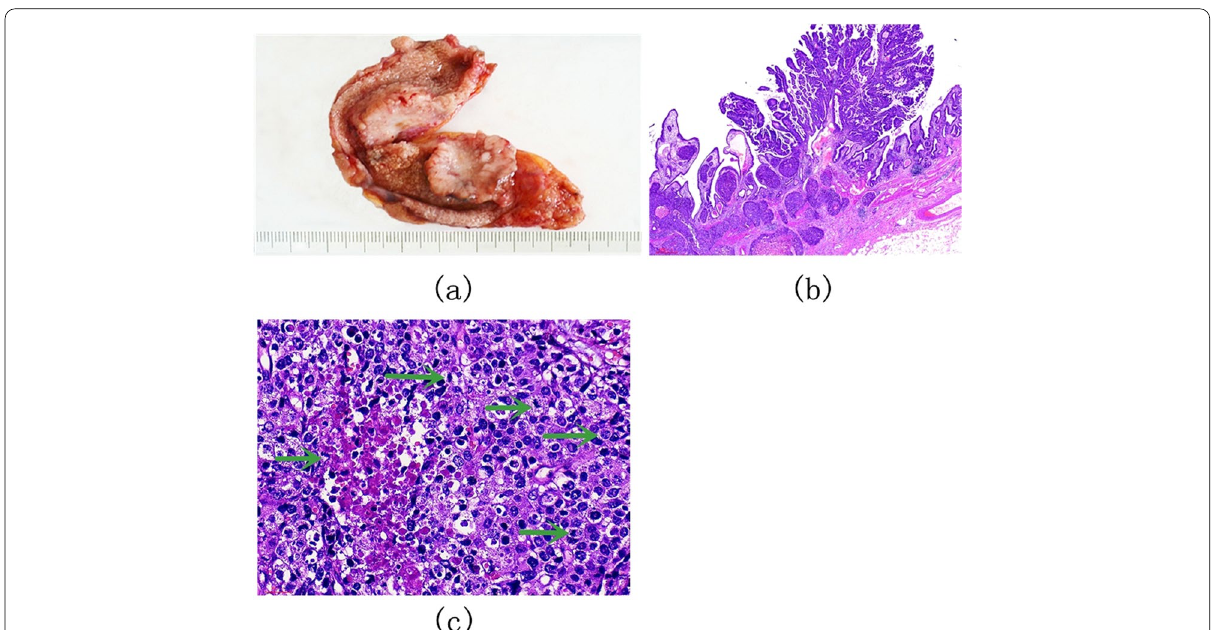
Fig. 4 Case 2: Gross pathological findings of the resected gallbladder and histological findings of MiNEN in the gallbladder, by hematoxylin and eosin (HE) staining. a The body of the gallbladder was a grayish-white type Isp mass. b Two components, LCNEC (lower left, show multiple irregular organoid nests) and moderately differentiated papillary adenocarcinoma (upper right), were present, showing a mixed transitional section between the two different tissue components. Magnification, 100. c Pleomorphic large cells with round to oval densely stained nuclei, visible nucleoli, × coarse chromatin, abundant eosinophilic cytoplasm, high mitotic index (arrowhead), and a patchy necrosis in the center of the nests were